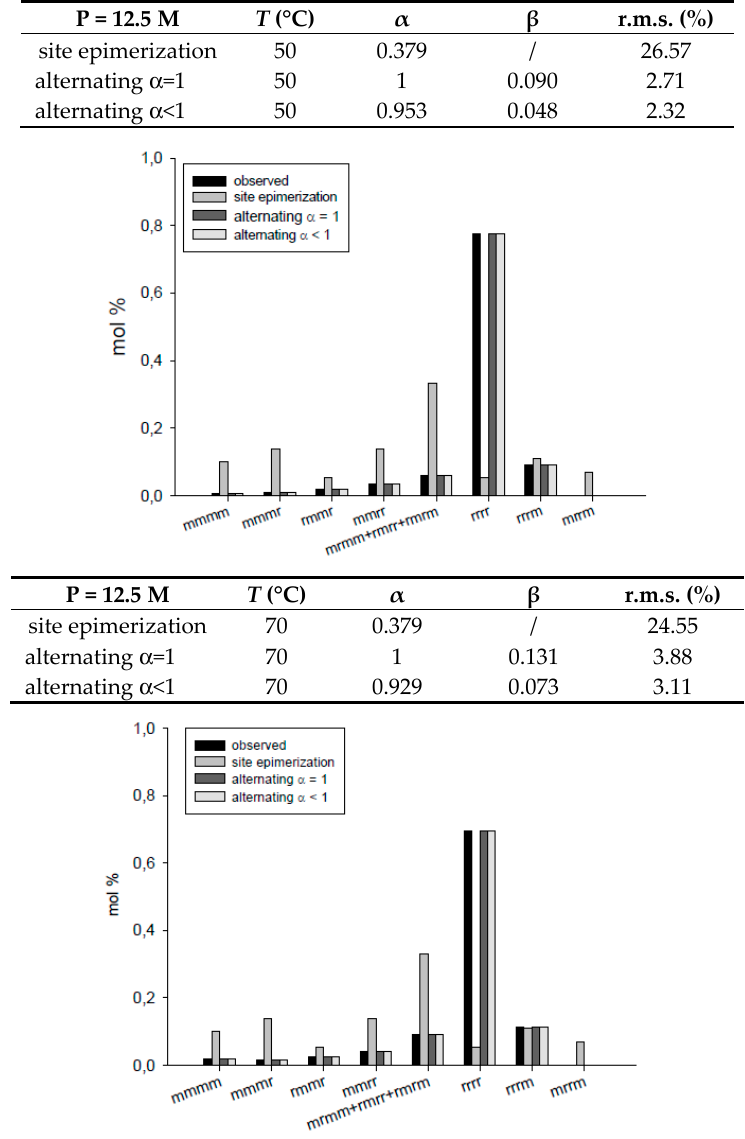
Figure 5. Statistical pentad analysis of a polypropene sample prepared with 2 /MAO at different